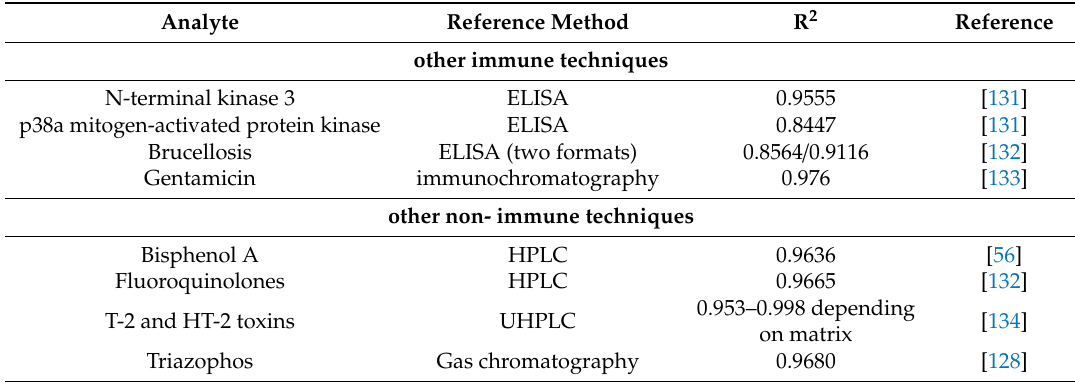
Table 3. Correlation of the FPA and other